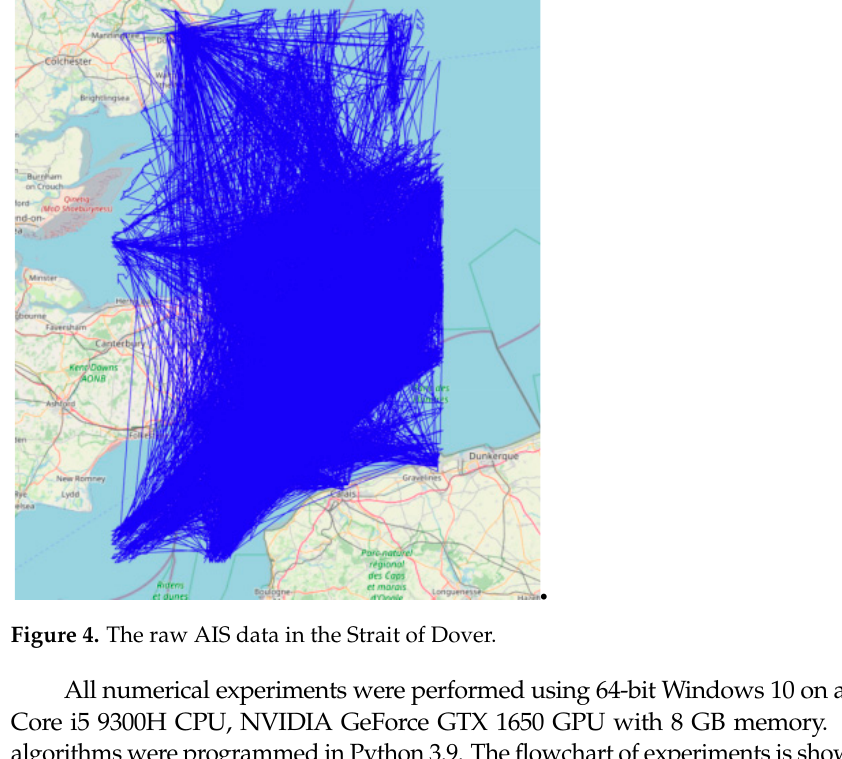
Figure 3. The raw AIS data in the Arctic Ocean.